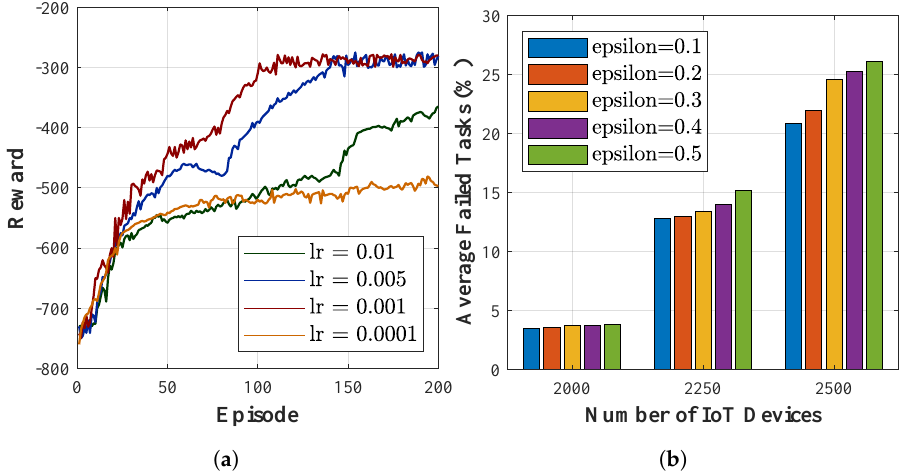
Figure 12. Study of variables in SARSA reinforcement learning: ( a ) Reward value through each episode with different learning rates. ( b ) Average task failure percentage with different epsilon